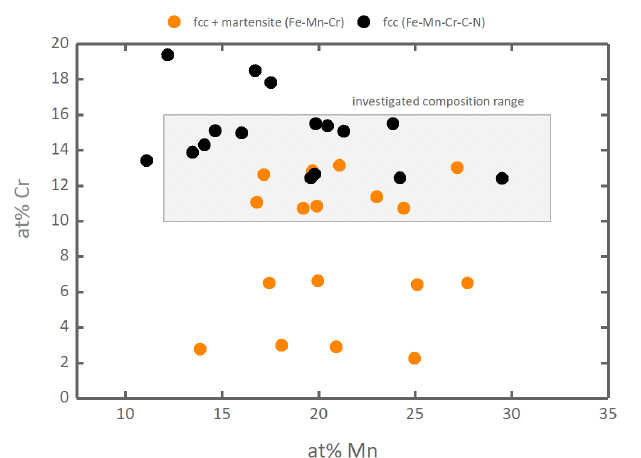
Figure 1. Experimental alloy compositions and their respective phases. Fe-Mn-Cr alloys (orange) are only experimentally obtained with a mixture of fcc and martensite [12], whereas Fe-Mn-Cr-C-N alloys (black) can be experimentally obtained with a fully austenitic microstructure [8,49–53]. For a detailed listing of the references, the reader is referred to the supplemental